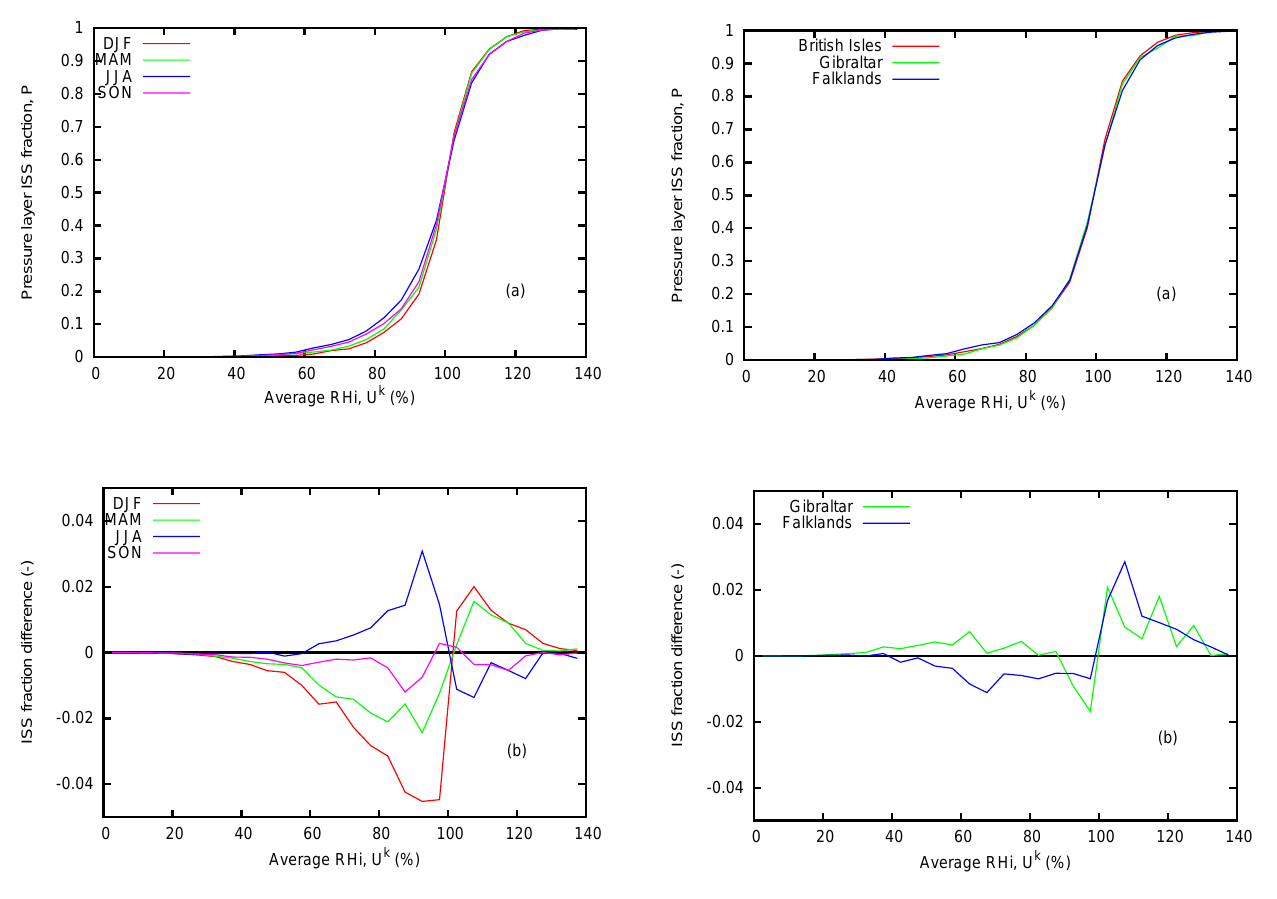
ISS events during the winter (10–25%) and less during the summer (5–15%) (Dickson et al., 2010). Therefore, the s-shaped curves are similar to the British Isles mean and the ISS fraction differences are well within the standard deviation of the British Isles dataset. Given this, the single British Isles s-shape curve could be used to represent both these mid-latitude